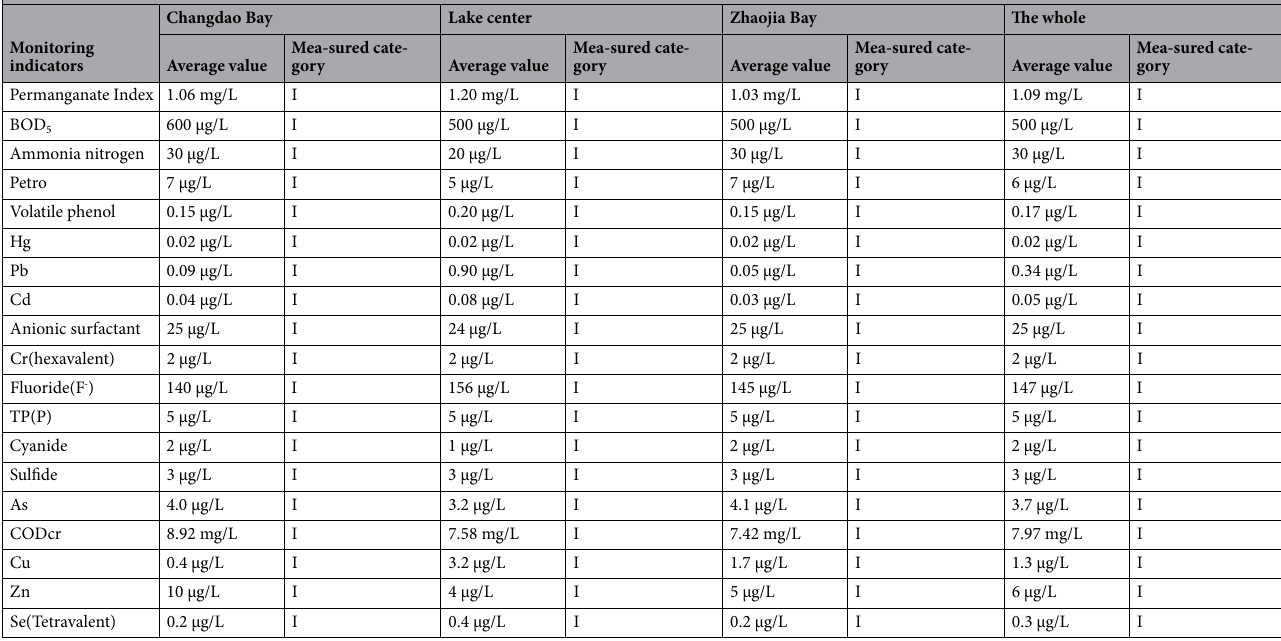
Table 3. Statistical results of various indicators in Lugu Lake in